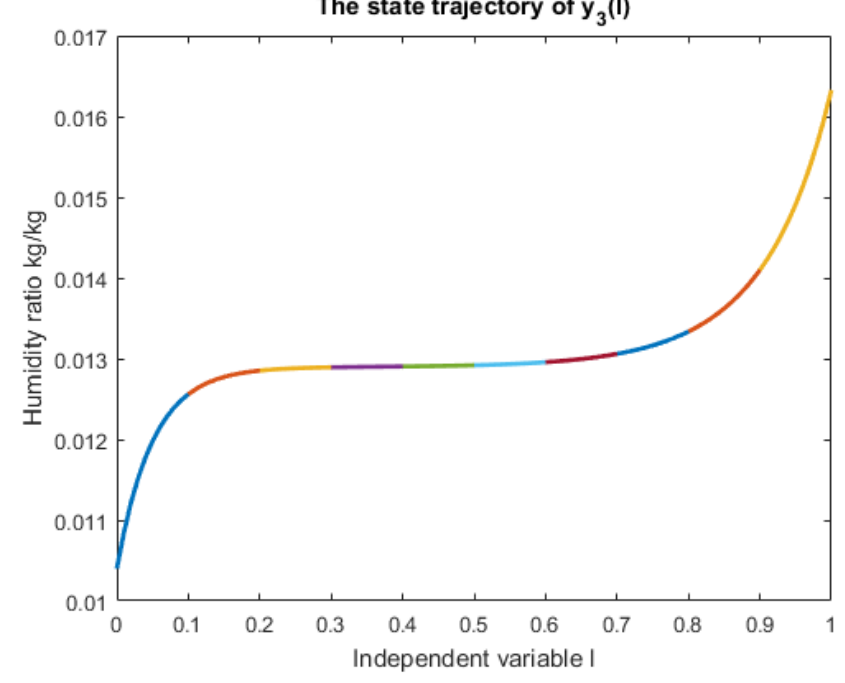
Figure 3. The trajectory of the state variable y 3 ( t )